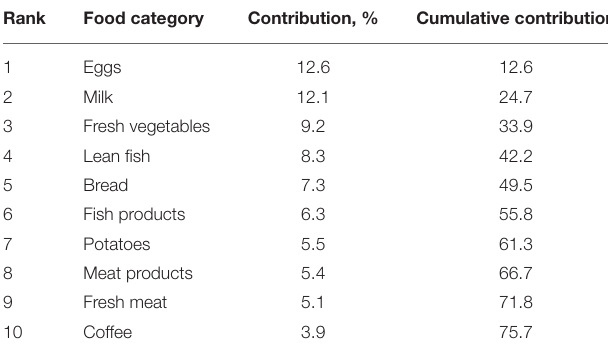
TABLE 5 | Primary food categories contributing to total choline intake in the study